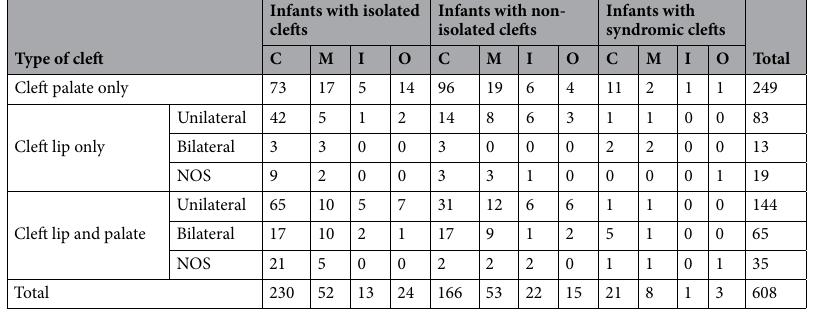
Infants with syndromic